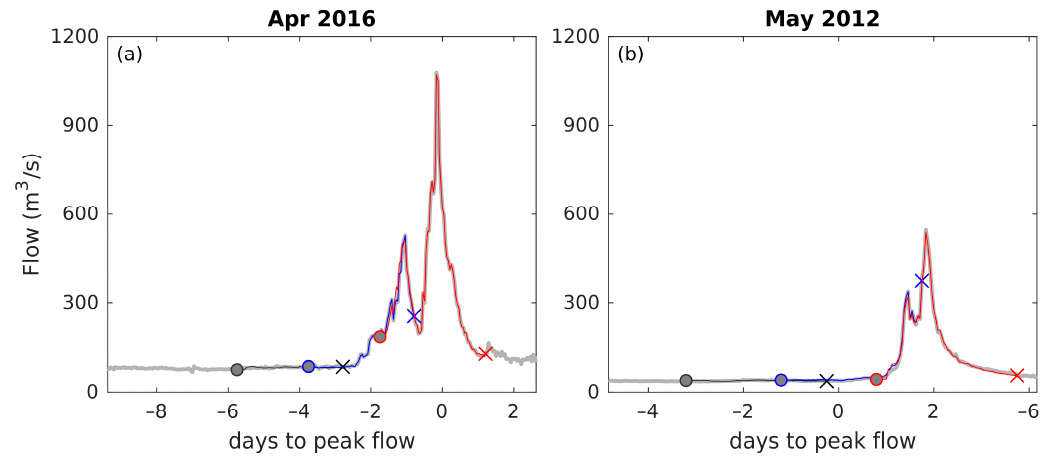
Figure 12. Time series of observed flow (grey line) for the events of ( a ) April 2016 and ( b ) May 2012 in Maipo en el Manzano station. Time series in black, blue and red are di ff erent predicted flows that star in the circle and ended with the x mark. Table 6. Errors of time to peak, ET p , and peak discharge, EQ p , calculated for di ff erent starting time of simulations with the DL weather-runo ff model for two flood events. The time 0 days 0 h corresponds to the time at which the maximum flow was